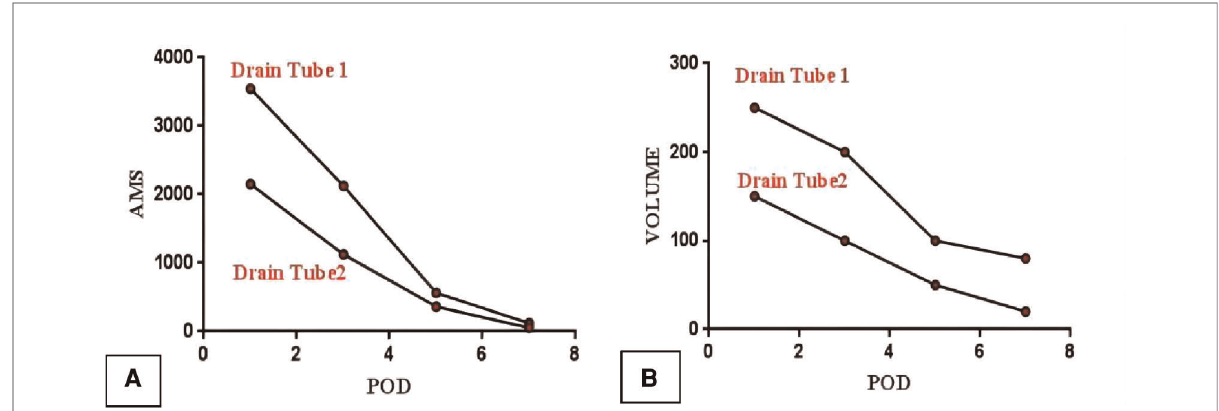
FIGURE 7 Postoperative outcome: the amylase ( A ) and volume of abdominal drainage tubes ( B ).